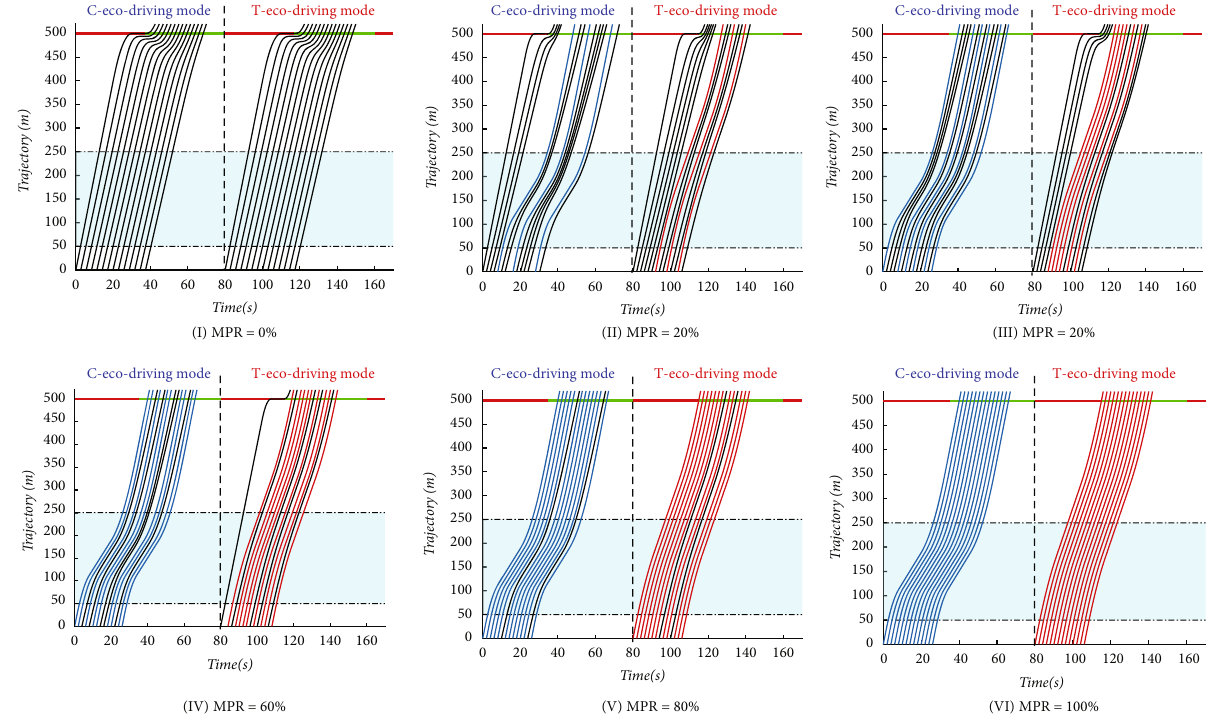
Figure 4: Spatial-temporal trajectories of six conditions (I ~ VI).